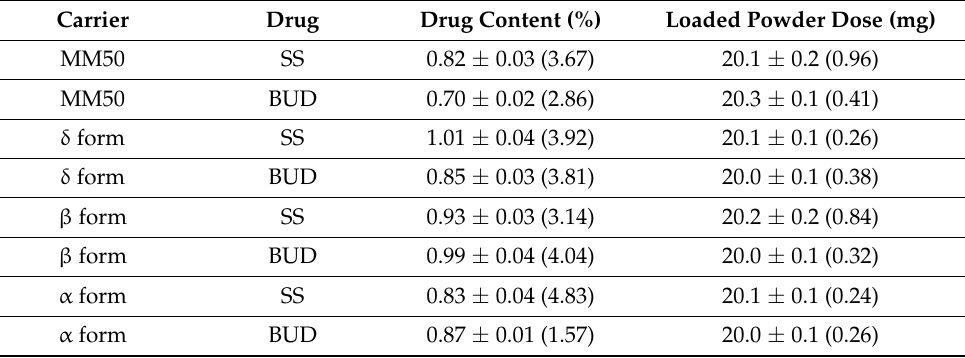
Table 2. Adhesive mixtures of salbutamol sulphate (SS) or budesonide (BUD) with different mannitol carriers and lactose MM50 as the reference. Actual drug content and loaded powder in capsules (mean value ± standard deviation, CV% in parenthesis ( n =